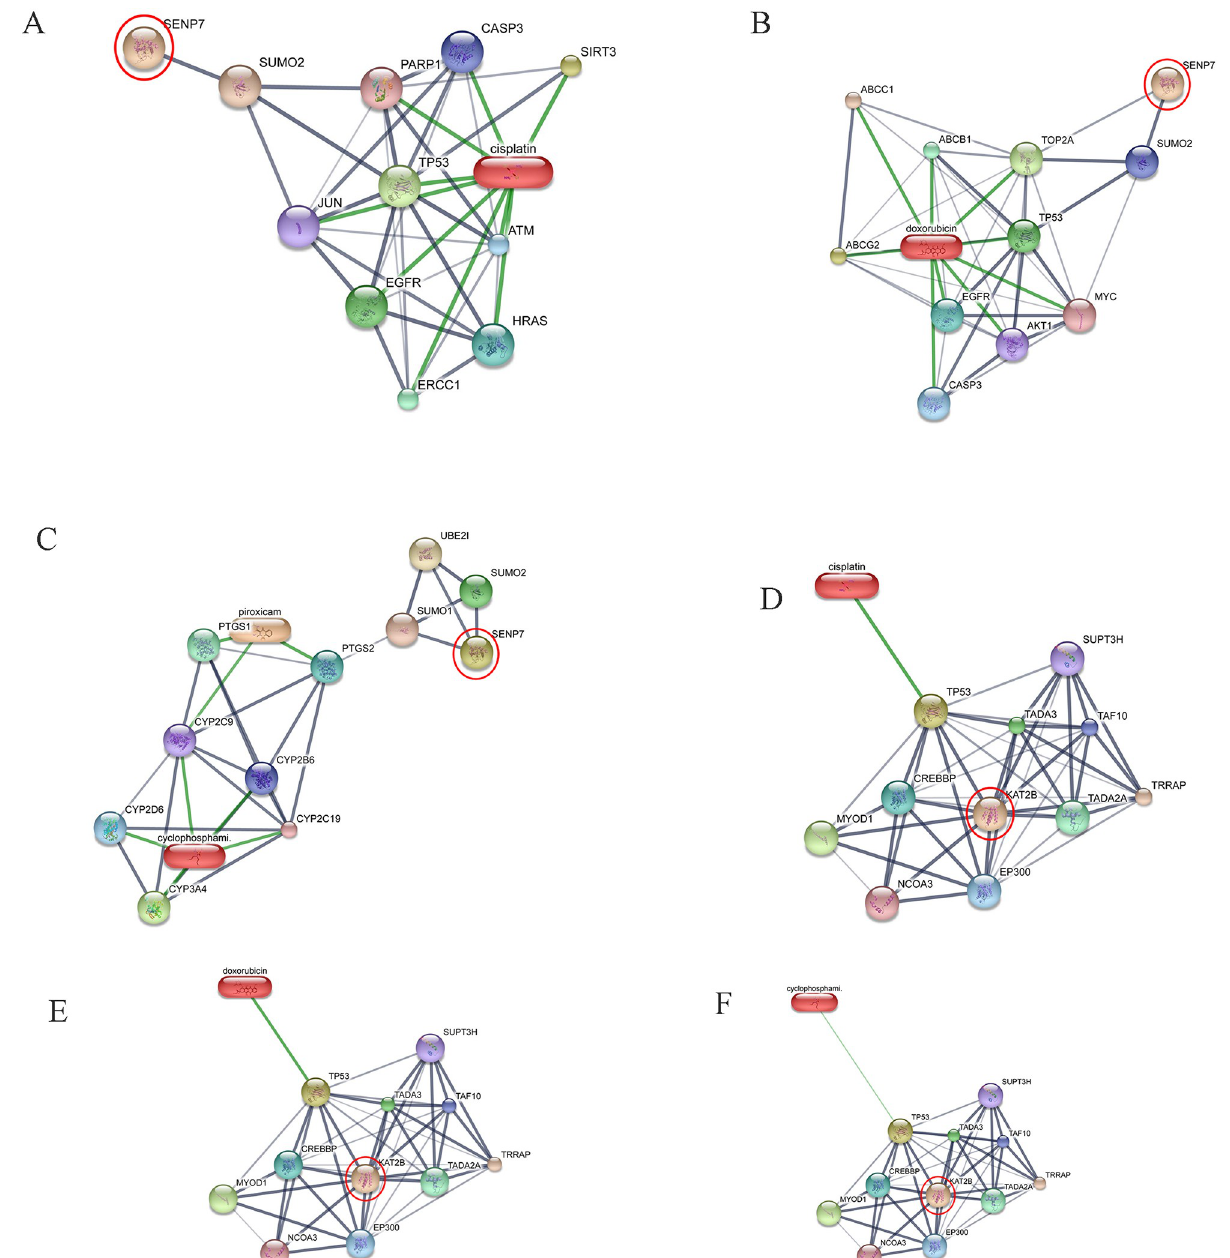
Fig 5. Involvement of sentrin-specific protease 7 (SENP7) and K(lysine) acetyltransferase 2B (KAT2B) in networks of protein–chemotherapy drug interactions, cisplatin, doxorubicin, cyclophosphamide and piroxicam. Interactions of SENP7 with cisplatin (A), SENP7 with doxorubicin (B) , SENP7 with cyclophosphamide and piroxicam (C) , KAT2B with cisplatin (D) , KAT2B with doxorubicin (E) , KAT2B with cyclophosphamide and piroxicam (F) were exhibited. Red circles: SENP7 and KAT2B. Abbreviations: ATP-binding cassette, sub-family B (MDR/TAP), member 1 (ABCB1), ataxia telangiectasia mutated (ATM), ATP-binding cassette, sub-family C (CFTR/MRP), member 1 (ABCC1), ATP-binding cassette, sub-family G (WHITE), member 2 (ABCG2), v-akt murine thymoma viral oncogene homolog 1 (AKT1), caspase 3 (CASP3), c-jun (JUN), CREB binding protein (CREBBP), cytochrome P450 family 2 subfamily B member 6 (CYP2B6), cytochrome P450 family 2 subfamily C member 9 (CYP2C9), cytochrome P450 family 2 subfamily C member 19 (CYP2C19), cytochrome P450 family 2 subfamily D member 6 (CYP2D6), cytochrome P450 family 3 subfamily A member 4 (CYP3A4), E1A binding protein p300 (EP300), epidermal growth factor receptor (EGFR), v-myc myelocytomatosis viral oncogene homolog (MYC), DNA excision repair protein ERCC-1, endonuclease non-catalytic subunit (ERCC1), Harvey rat sarcoma viral oncogene homolog (HRAS), myogenic differentiation 1 (MYOD1), nuclear receptor coactivator 3 (NCOA3), poly [ADP-ribose] polymerase 1 (PARP-1), prostaglandin- endoperoxide synthase 1 (PTGS1), prostaglandin-endoperoxide synthase 2 (PTGS2), sirtuin 3 (SIRT3), solute carrier family 30 (zinc transporter),